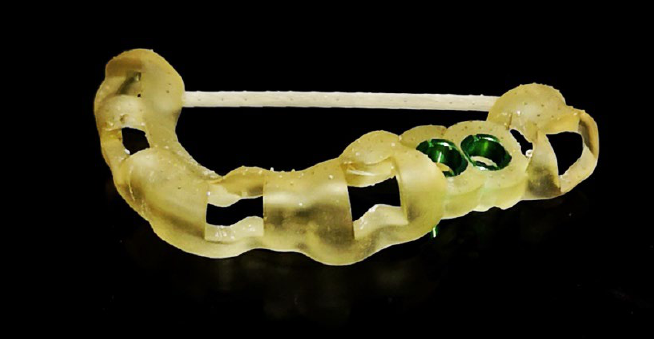
Figure 7. Surgical templates printed using a 3D printer personalized to the patient’s anatomical features, fitted on CT scan and oral scanner. Used to facilitate and speed up the surgical procedure of dental implants. Material from the authors’ collection.